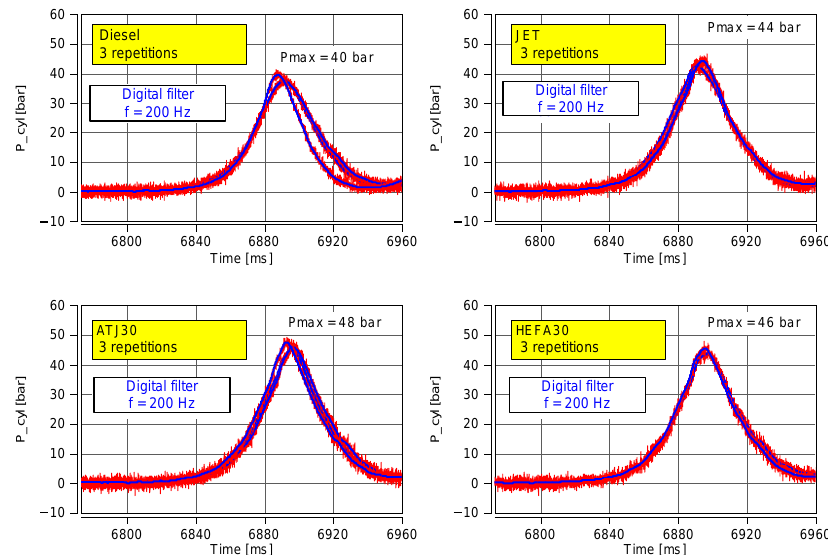
Figure 7. Assessment of the cylinder pressure curve inside the RCEM cylinder using three repetitions of combustion of a given fuel.